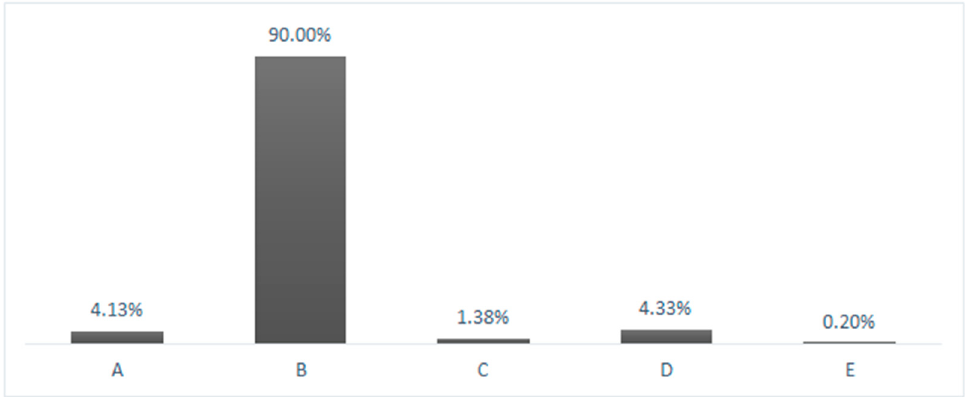
Figure 2. Most frequent treatment strategy for carpal tunnel syndrome. A: Massage therapy, instrumental therapy; B: Education, manual therapy, myofascial therapy, therapeutic exercise; C: Joint mobilization of the radiocarpal joint, stretching; D: None of the previous answers; E: Missing values